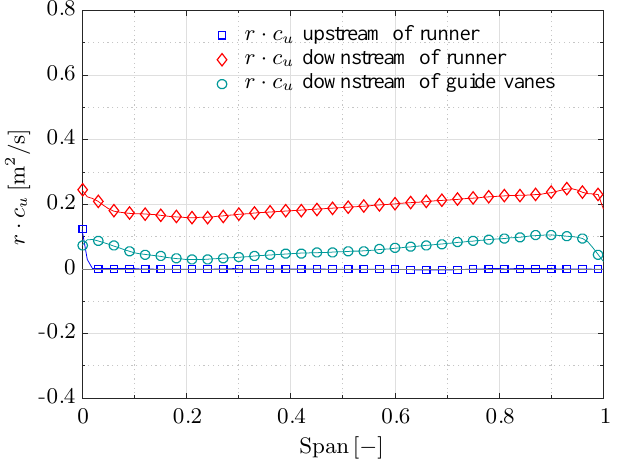
Fig. 15. Distribution of r · c u upstream and downstream of the runner and downstream of the guide vanes in pumping mode The swirl distribution is slightly skewed with a higher magnitude near the shroud. After passing the guide vanes, most of the swirl is removed again as the flow is